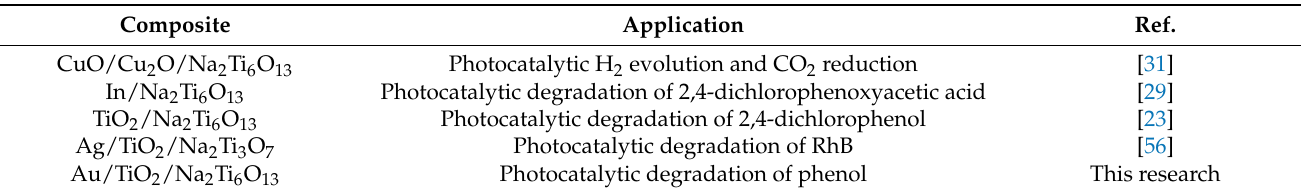
Table 4. Comparison of various composites of Na 2 Ti 6 O 13 and their